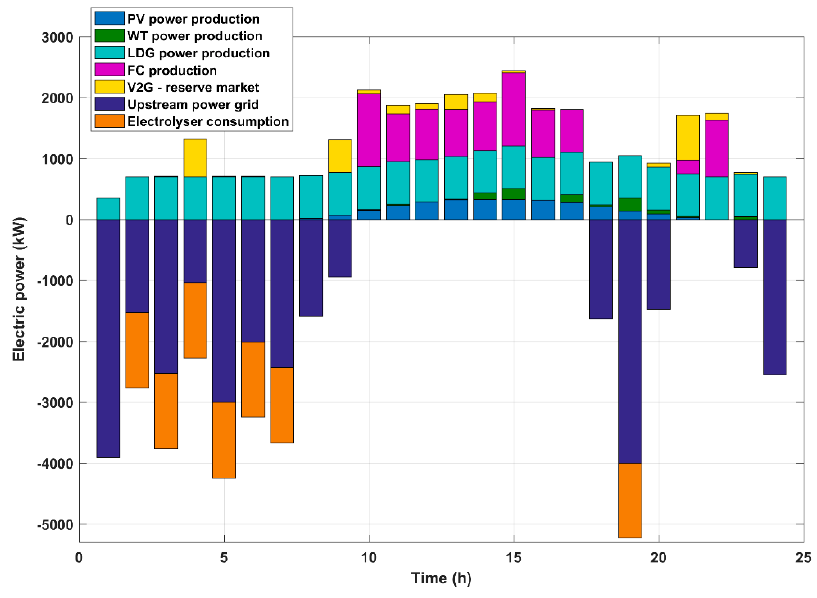
response program (DRP) obtained in Case Study 3.